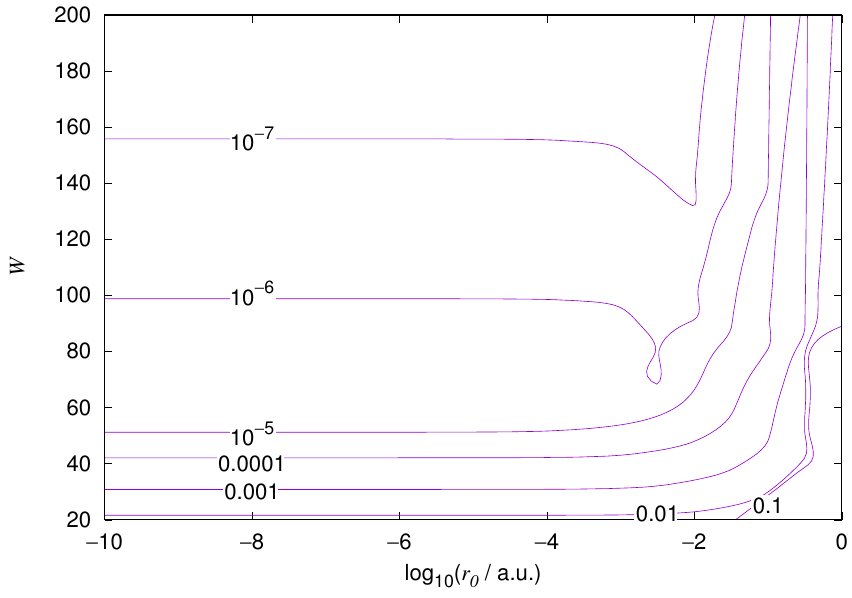
Figure 1. Hydrogen 1s orbital eigenenergy relative error. The r 0 is the EPP radius in atomic units and W is the basis size.